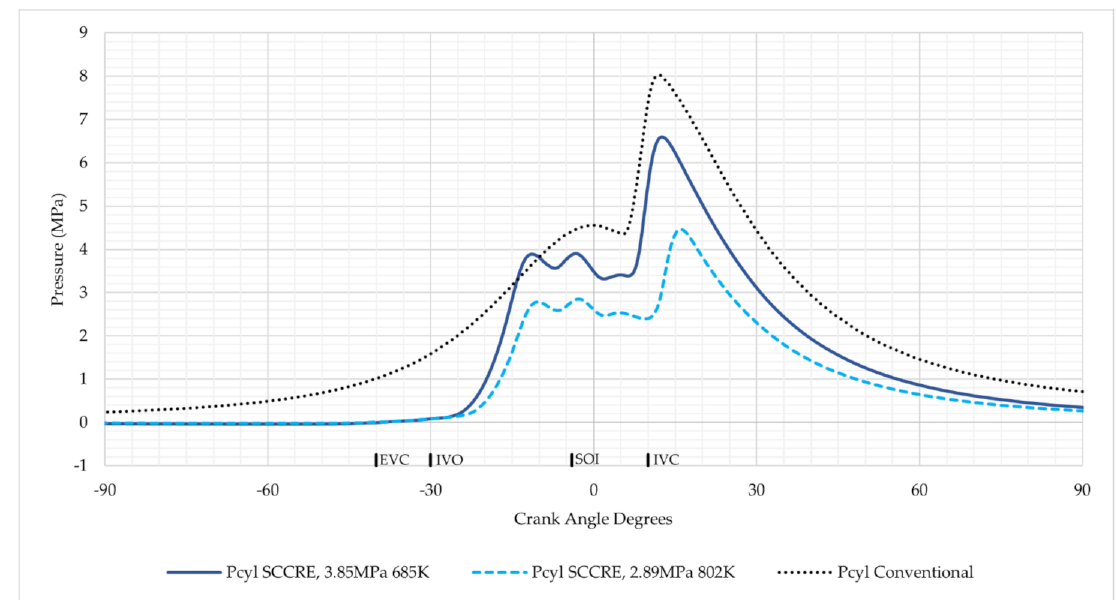
Figure 2. Comparison of three pressure traces. Two from the SCCRE at 1200 RPM and one from a conventional Diesel engine at 2000 RPM. All at 0.69 equivalence ratio (21 AFR). SCCRE data adapted from Ref. [8] with permission. © SAE International.